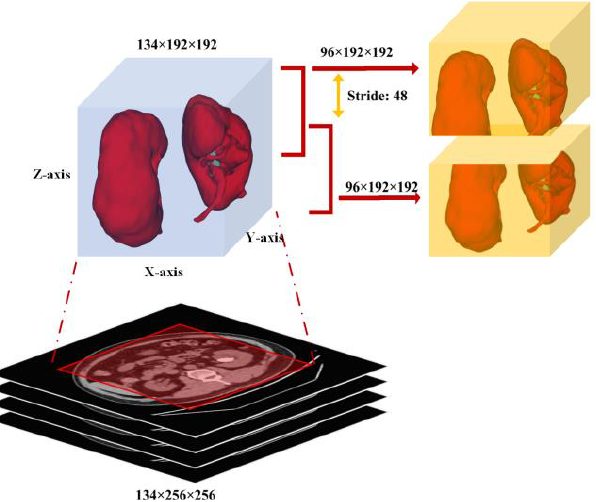
Figure 4. Each cropped cube with shape (1, 96, 192, 192) as input to the first segmentation network for coarse kidney segmentation.